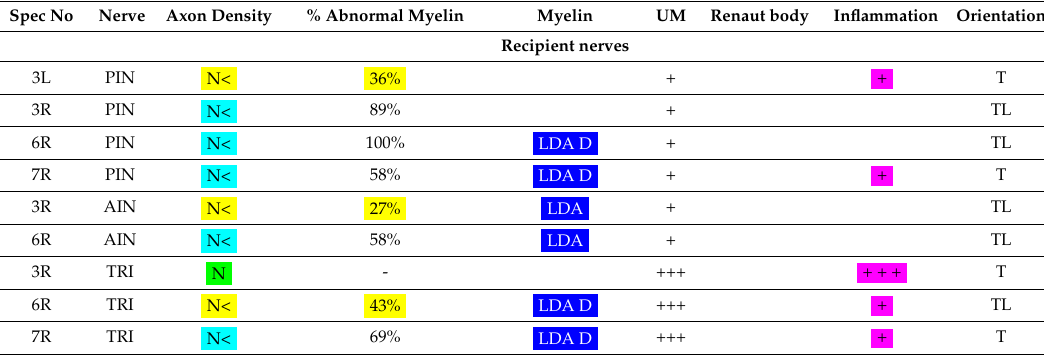
Table 2. Qualitative assessment of nerve